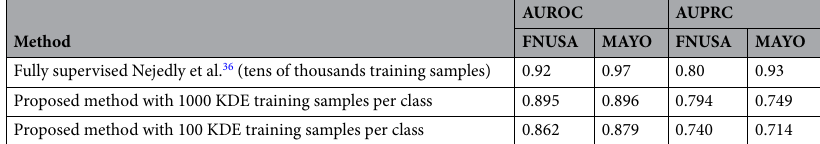
Table 5. Comparison of the proposed method with fully supervised state-of-the-art method.